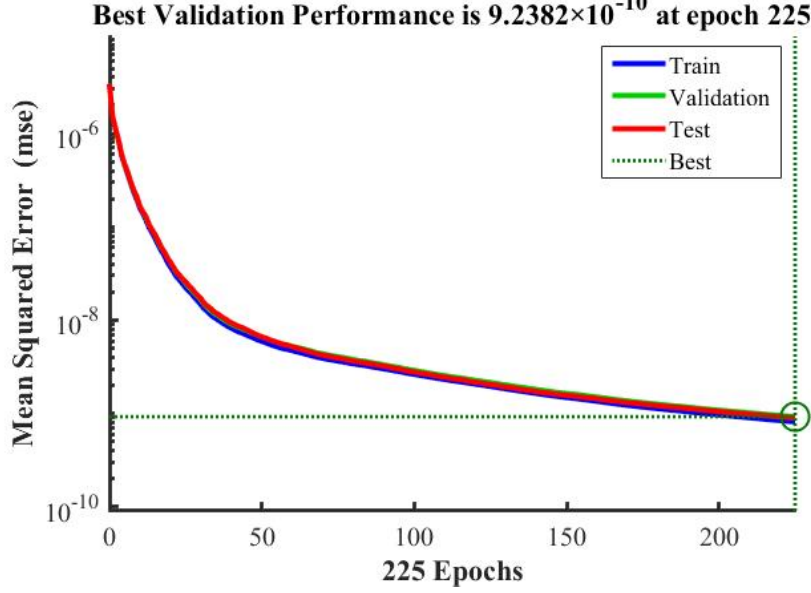
Figure 13. Error graph during the training, testing, and validation of the DNN model.